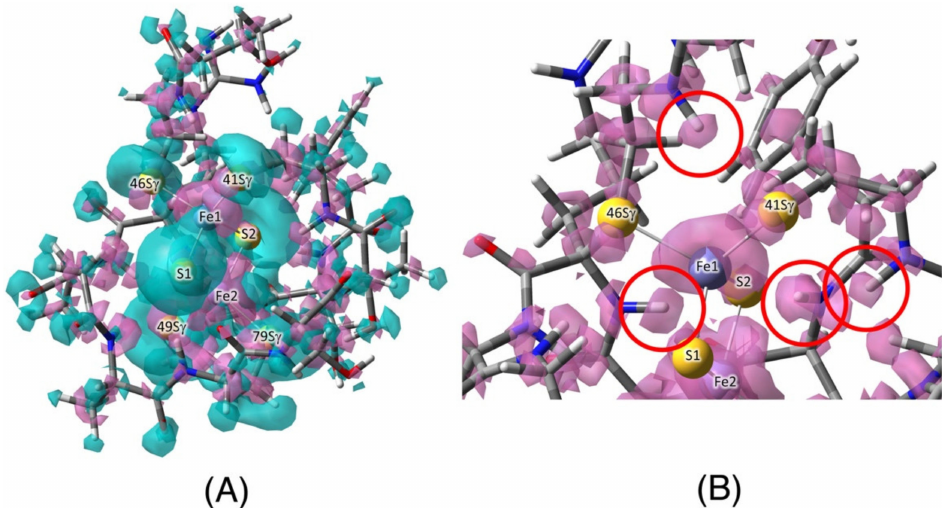
Figure 4. ( A ) An electron density difference map ( ∆ ρ ) between the oxidized ( ox ) and reduced ( red ) states ( ρ ( ox )– ρ ( red )). Purple and blue colors show positive and negative distributions, respectively. ( B ) Enlarged view around active sites, which shows only the purple distribution. The areas indicated by circles show positions of the hydrogen atoms concerned with the hydrogen